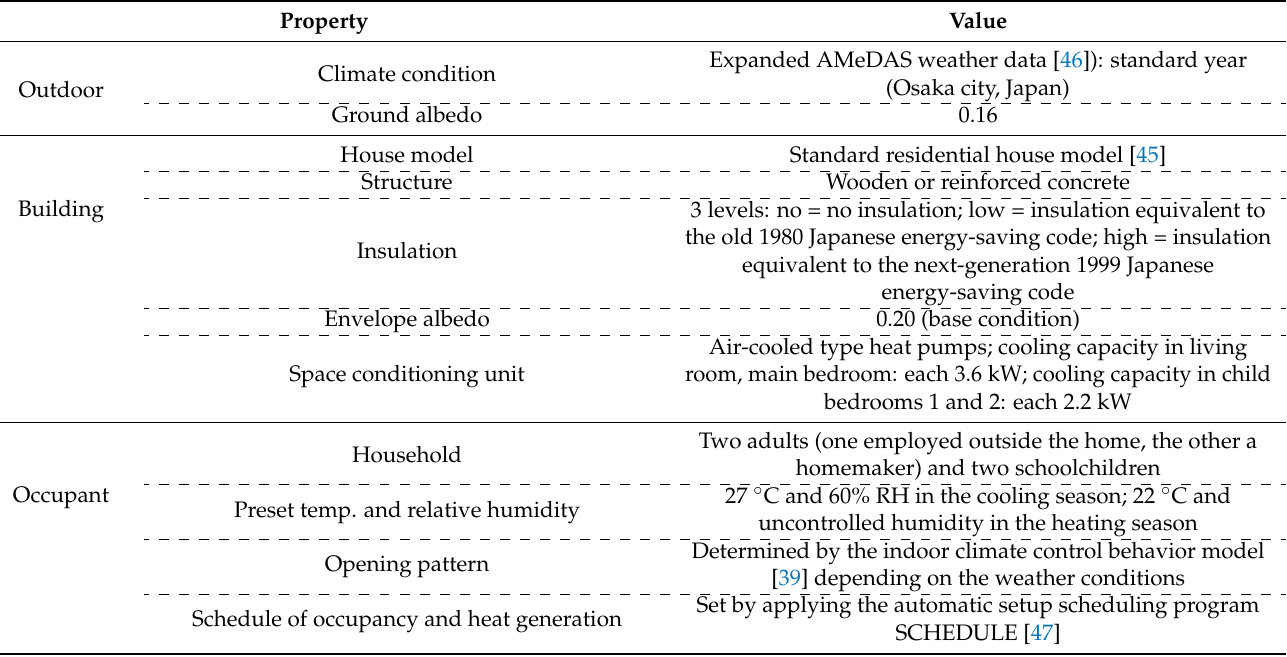
Figure 3. Plan view of the targeted detached house. Table 1. Outline of the computational